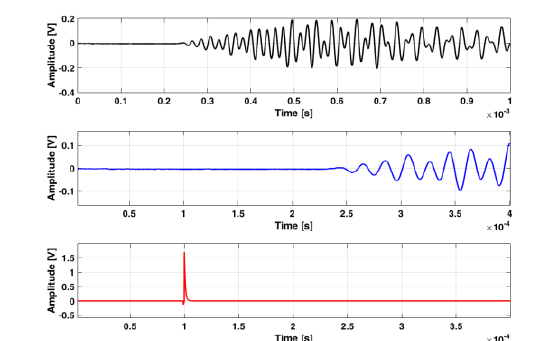
Figure 9. Top: raw US signal; Middle: zoomed US signal to read the TB; Bottom: Triggering signal from which the time-